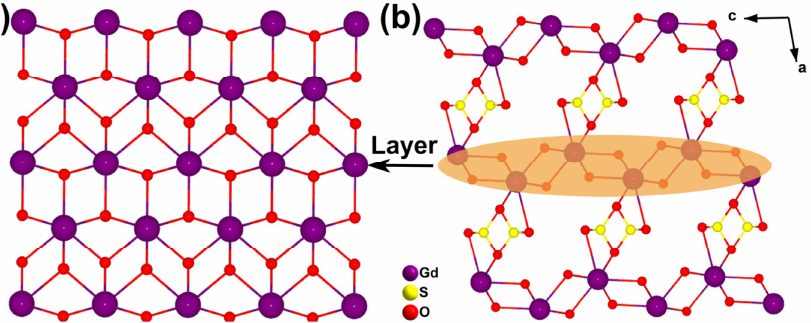
Figure 2. ( a ) The layer structure of [Gd 2 (OH) 4 ] n2n+ ; ( b ) the connection mode of SO 42 − between adjacent layers in 2 . Hydrogen atoms are omitted for clarity.